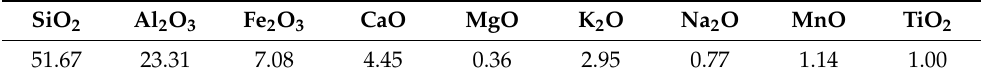
Table 1. Chemical composition of fly ash (%).